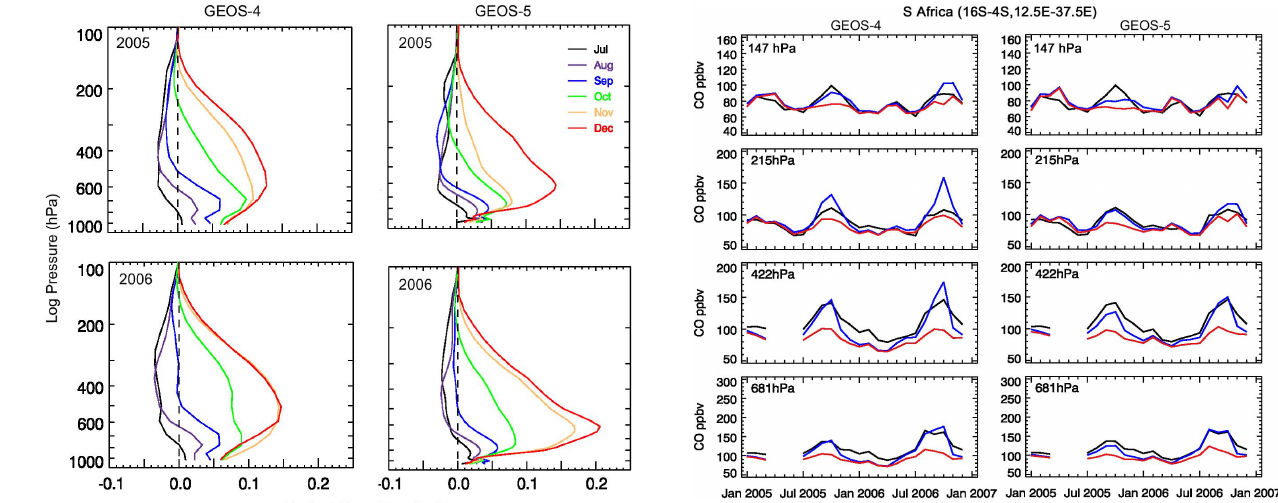
Fig. 19. Vertical profiles of total air mass flux (convection and ad- vection) in southern Africa from August to December in 2005 (top) and 2006 (bottom). The left panels are for GEOS-4 and the right panels are for GEOS-5.